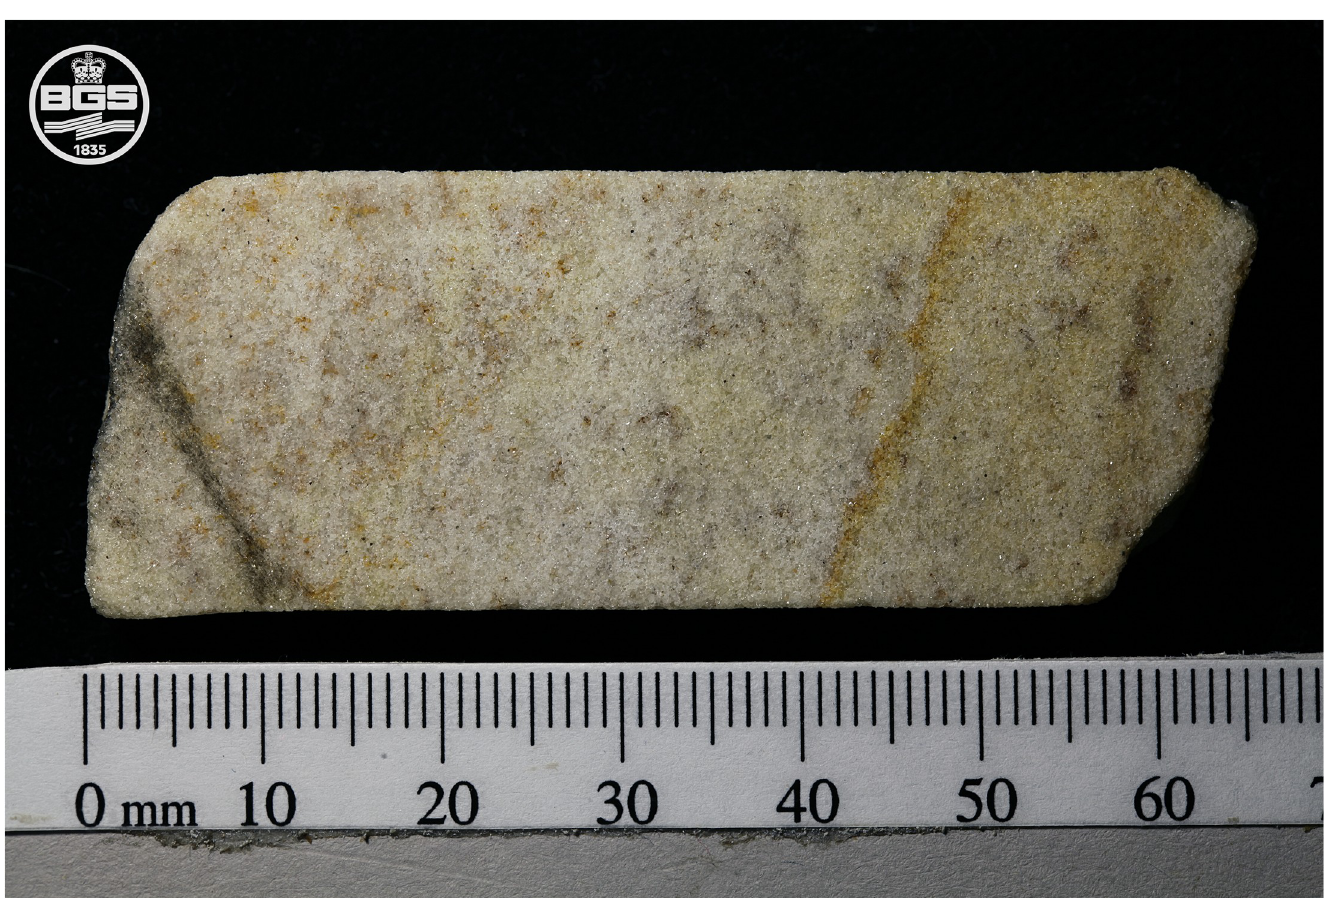
Fig 7. Image of section 2–3 of the Phillips’ Core from Stone 58 at Stonehenge. The right-hand end of the core segment represents a natural fracture in the original sarsen, with the thin band of iron hydroxide staining running diagonally from ~40 to ~50 mm mirroring the fracture surface. The left-hand end of the core represents a break developed either during or after drilling. The grey diagonal band running from ~10 to ~0 mm is residual metal from the diamond saw blade smeared onto the surface of the sarsen during cutting. This image is reproduced under a CC BY 4.0 license, with permission from British Geological Survey, original copyright (2019).